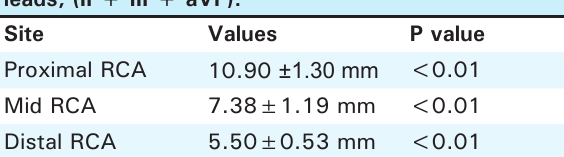
Table 5. Total ST segment elevation in inferior leads, (II + III +